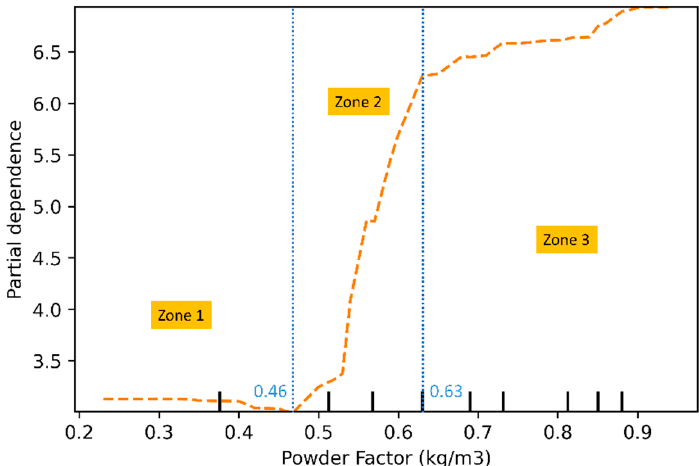
Figure 15. The partial dependency between the PPV and PF.